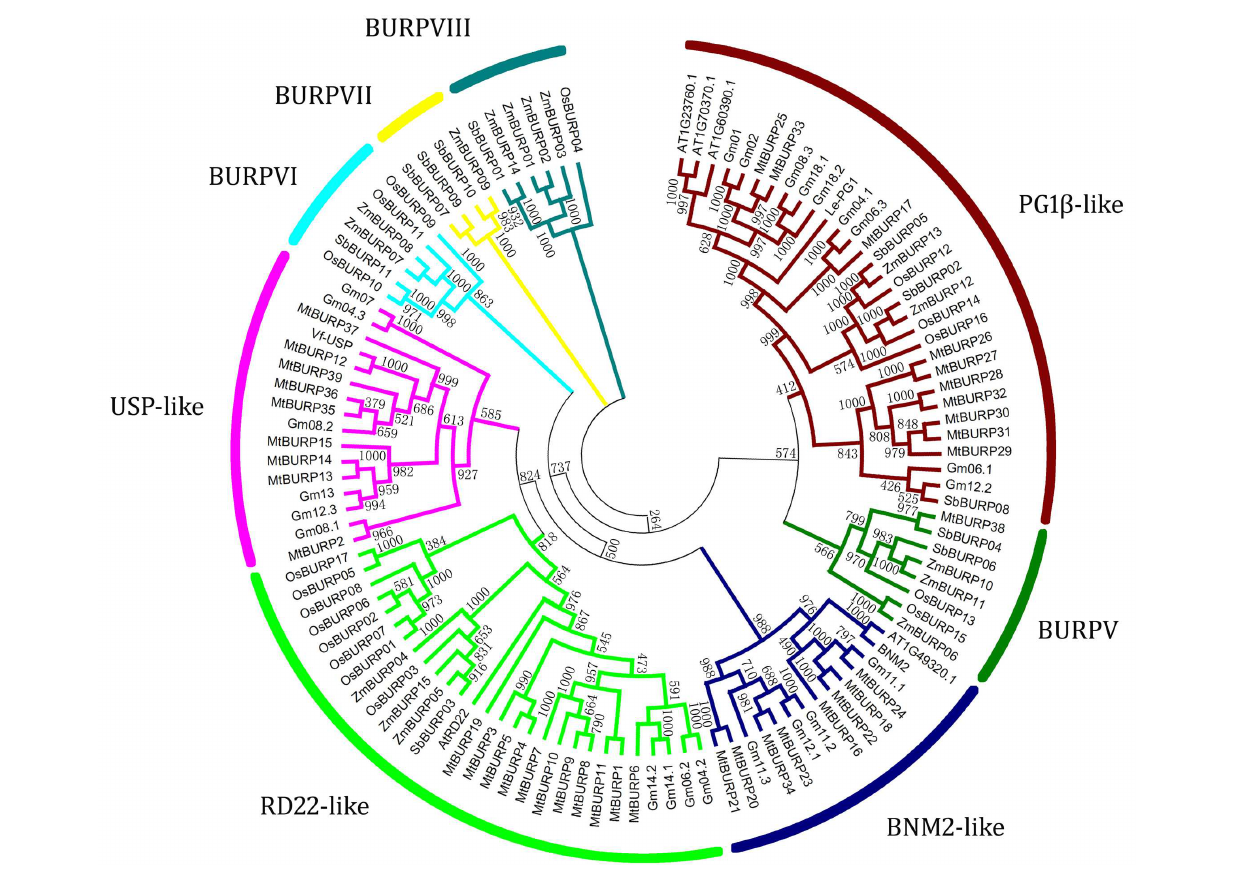
FIGURE 2 | Phylogenetic tree of Medicago truncatula , Arabidopsis, Lycopersicon, and Vicia BURP genes. The unrooted tree was generated using the Clustal X program with the neighbor-joining method. The bootstrap values are indicated on the branches. At, Arabidopsis thaliana ; Le, Solanum lycopersicum ; Mt, Medicago truncatula ; Vf, Vicia faba